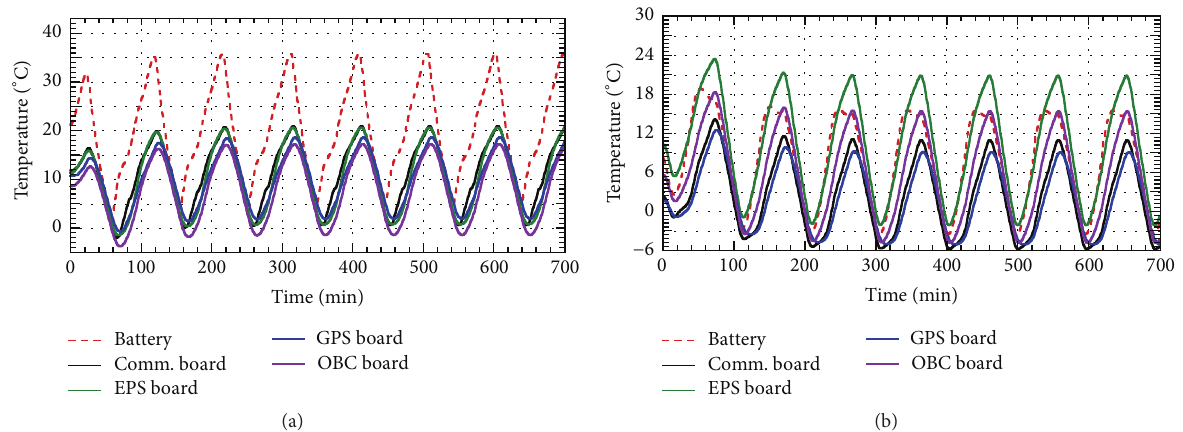
Figure 12: Temperature profiles of electronic boards ((a) worst hot case, (b) worst cold case).